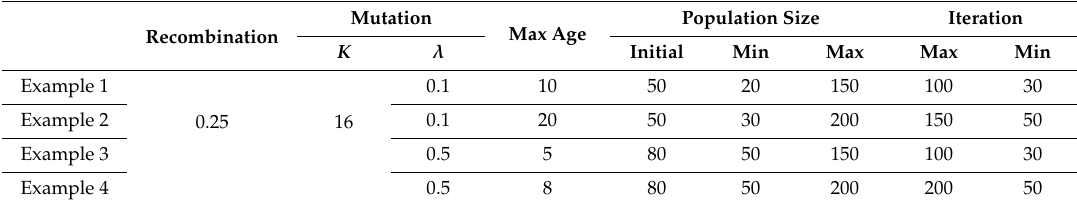
Table 2. Parameters of the